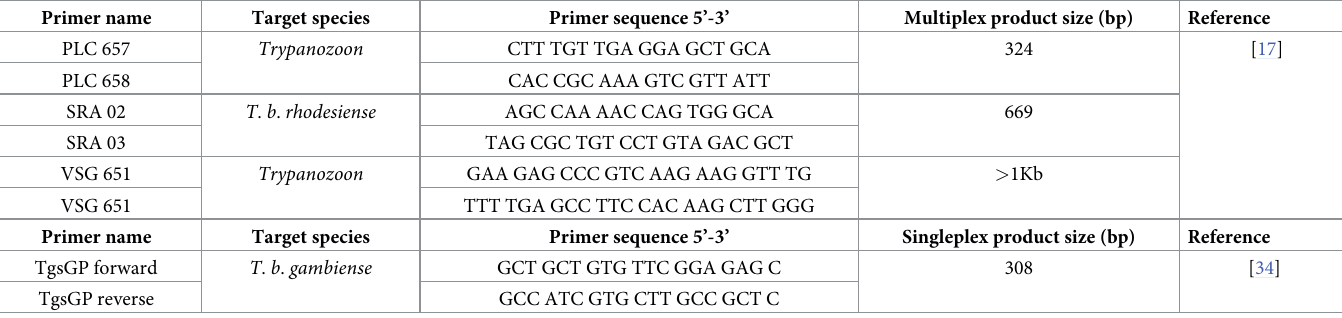
Table 3. Primers for single copy gene detection and sub-species-specific